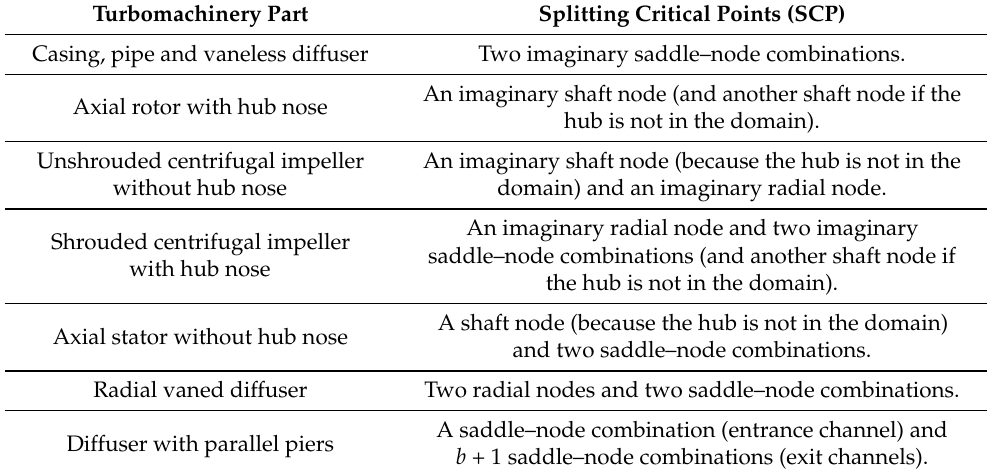
Table 2. Recommended splitting critical point.